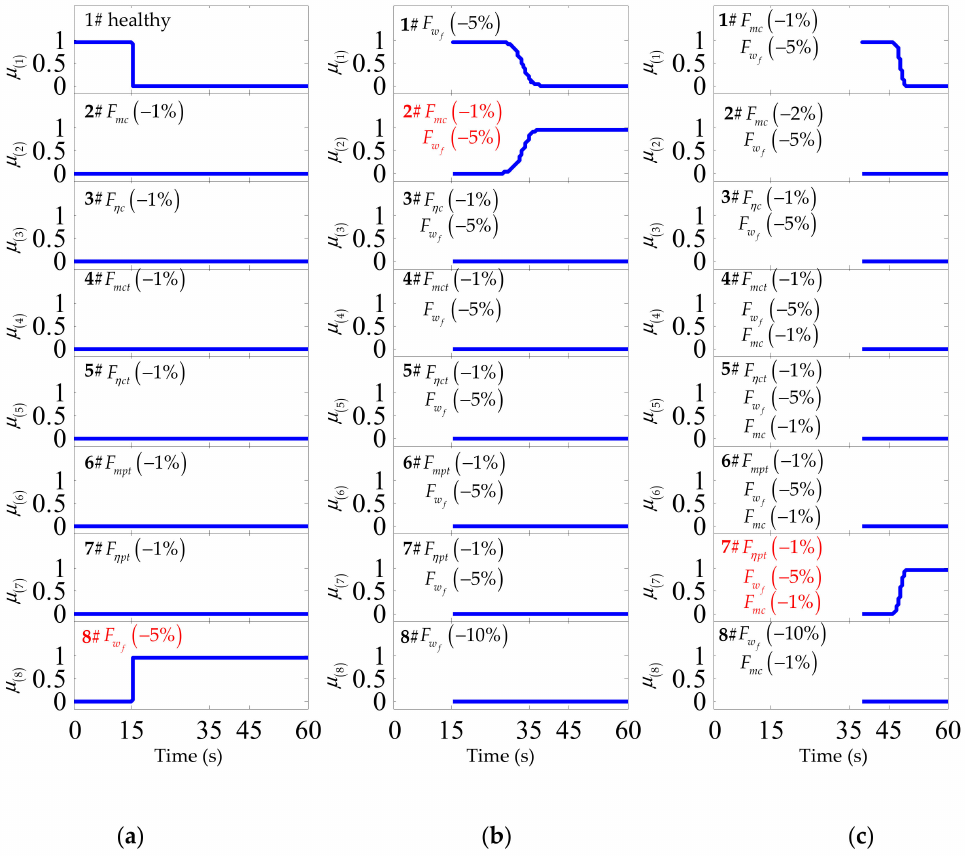
Figure 13. The multiple faults detection and isolation results in the scenarios of F wf decreases by 5% fault occurs at t = 15 s, F mc decreases by 2% fault occurs at t = 35 s, and F η pt decreases by 1% fault occurs at t = 45 s. ( a ) The conditional probability of the initial model set; ( b ) The conditional probability of the updated model set 1; ( c ) The conditional probability of the updated model set